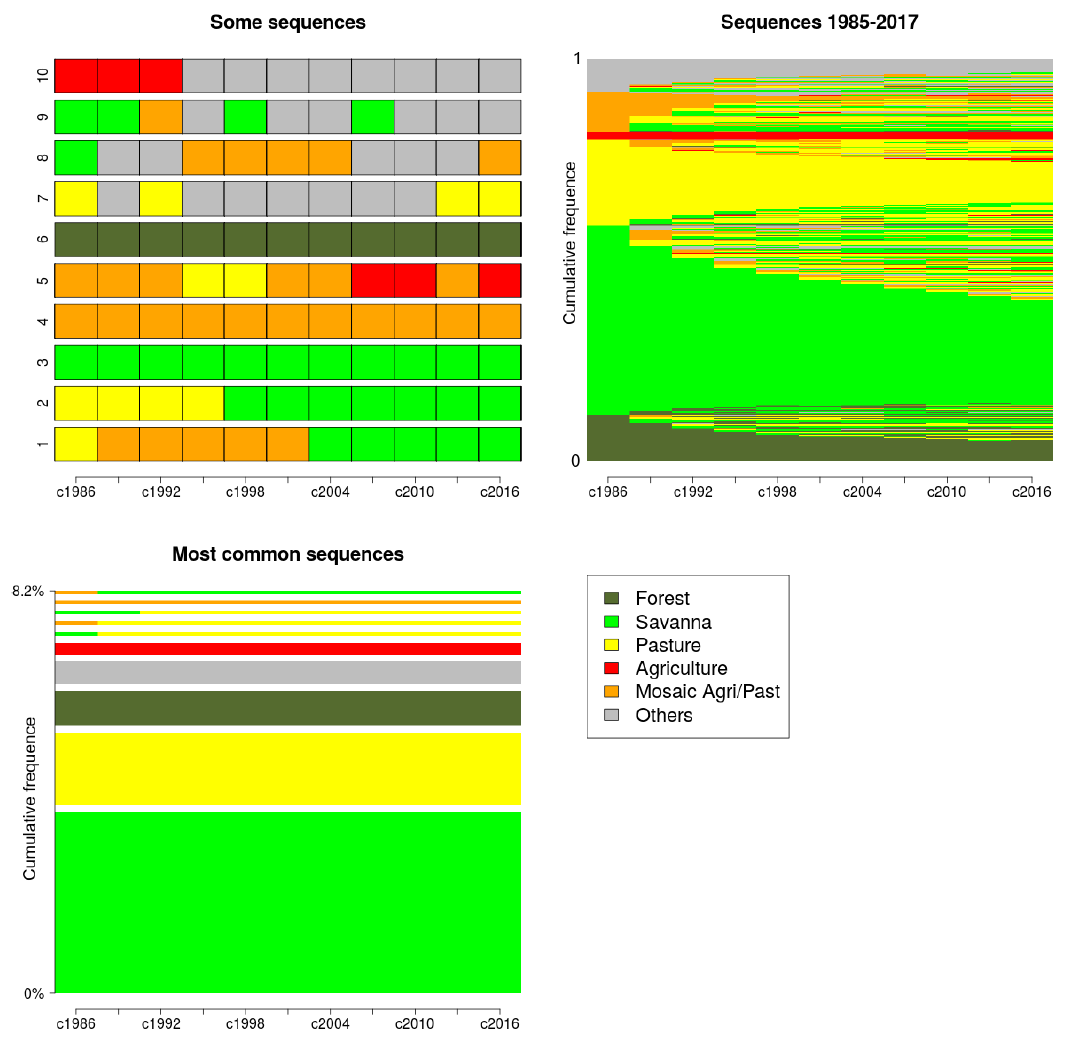
Figure 4. Descriptive representation of the land use/cover